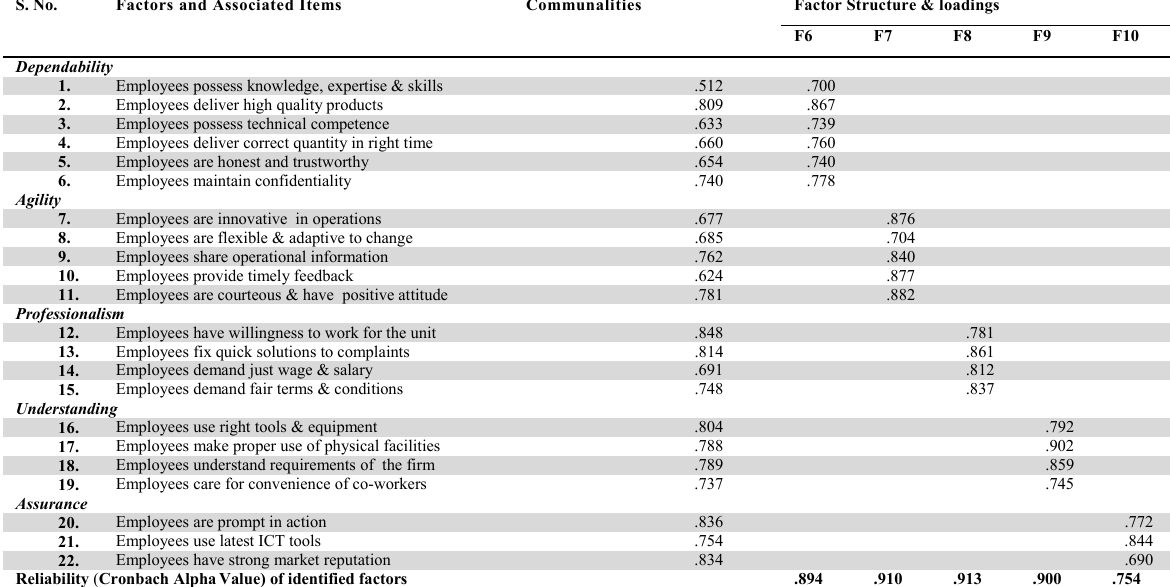
C ommunalities, Factor Structure and Loadings for Items of Scale for measuring ESQ Principal Components Method with Varimax Rotation Loading ≥ .55 * S.